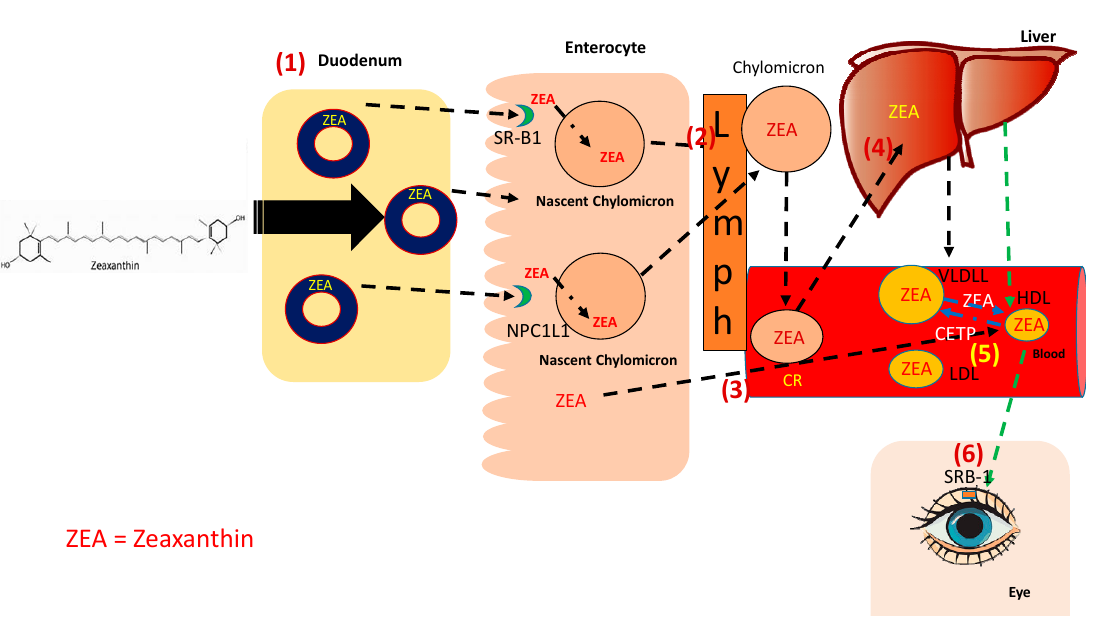
Figure 1 . Metabolism of Zeaxanthin. Absorption, Uptake, and Trafficking: (1) Esterified zeaxanthin (ZEA), after being hydrolyzed, is incorporated into the micelles [14] and can be taken up by the enterocyte by two receptors, SR-B1 and NPC1L1 [37]. ZEA can have two fates in the enterocyte: (2) it can be incorporated into the chylomicron via the action of microsomal transfer protein and be released to the lymphatics [38] or (3) can be directly incorporated into nascent HDL. (4) As the chylomicron is being delipidated by lipoprotein lipase, some ZEA can be taken up by the peripheral tissues and the rest return to the liver as chylomicron remnant [37]. (5) ZEA can also be part of HDL by the interchange of lipids between HDL and the TG-rich lipoproteins [43]. (6) ZEA is taken by the eye by SR-B1 via HDL [47]. SR-B1: scavenger receptor class B type 1. NPC1L1: Niemann-Pick C1-Like 1.